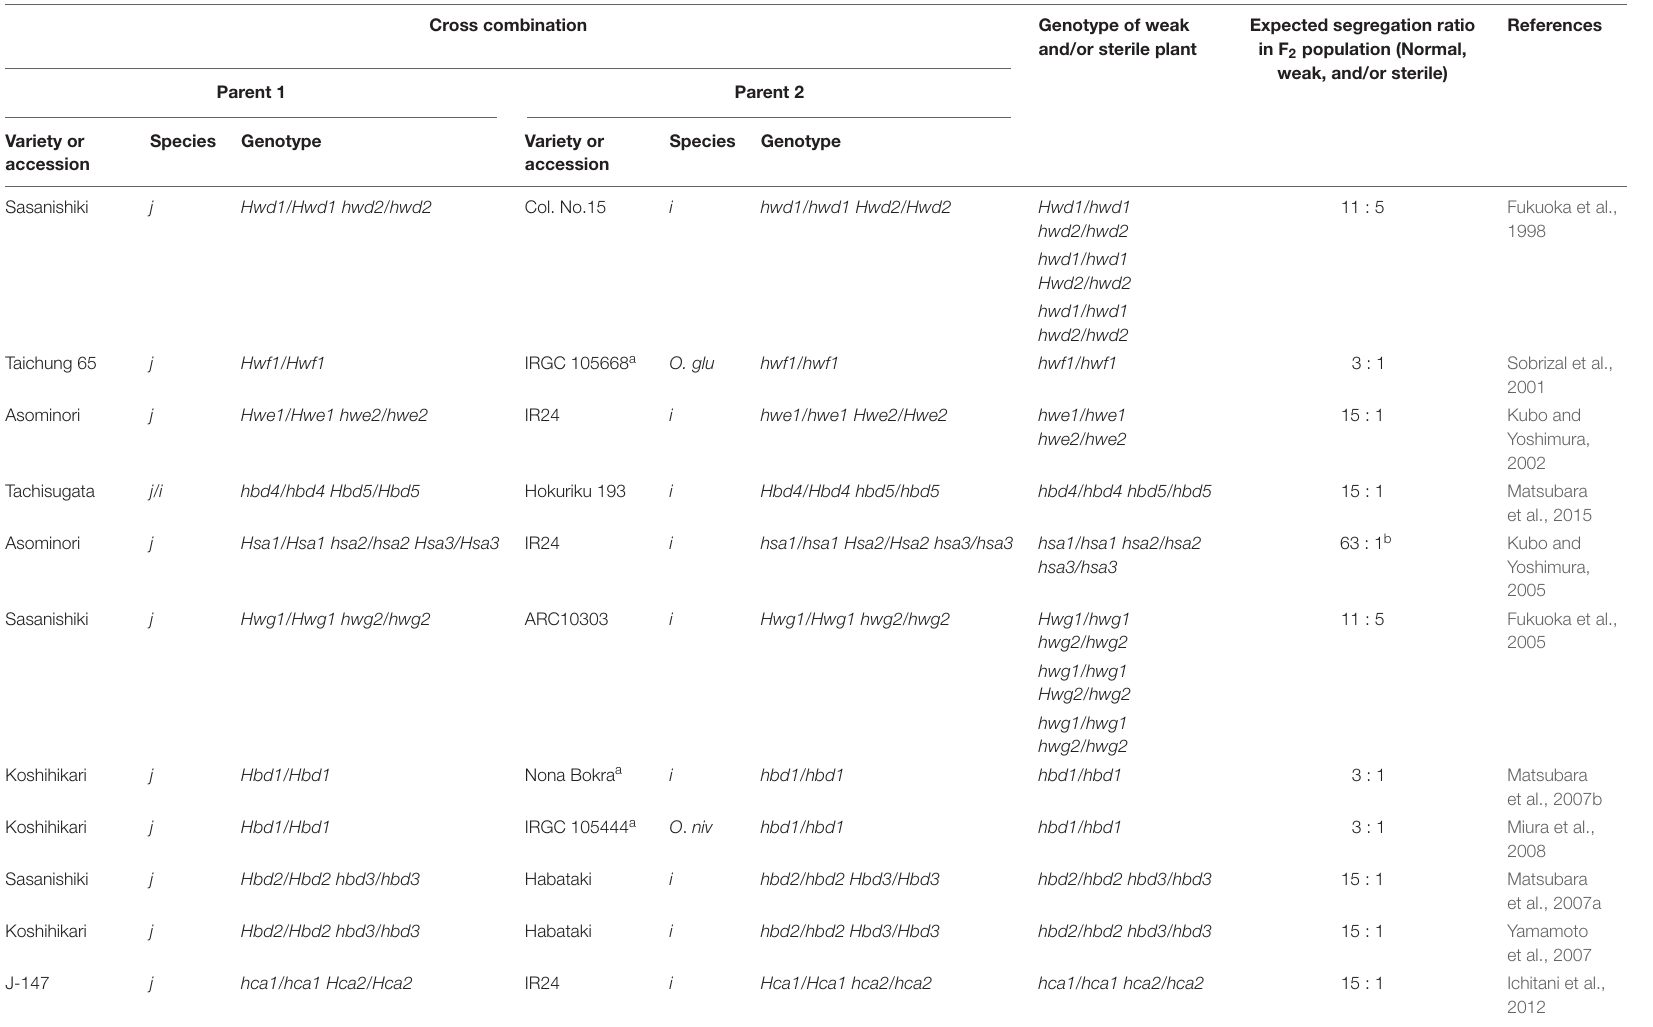
TABLE 1 | Genetic basis of the hybrid breakdown reported in rice crosses.